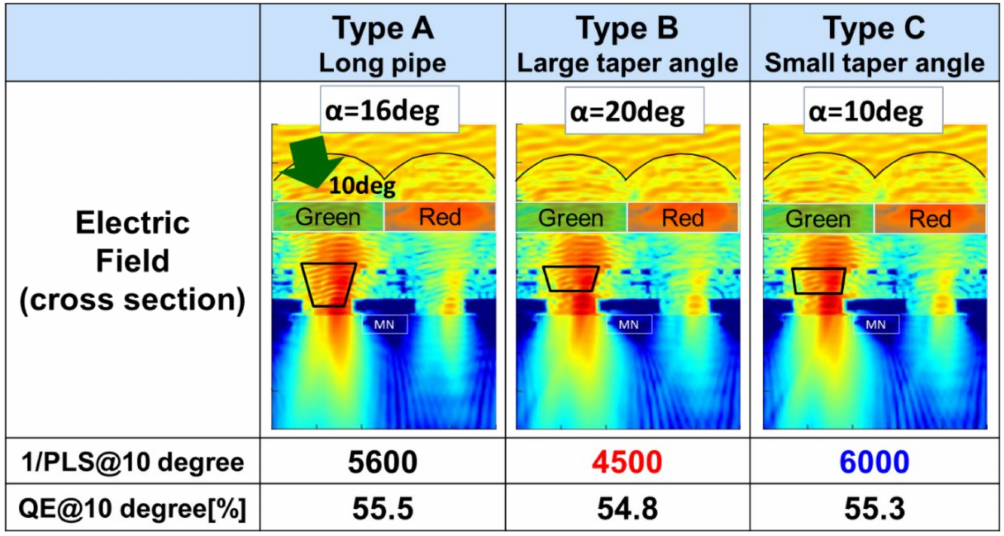
Figure 8. Comparison of three types of light pipes at an incident angle of 10